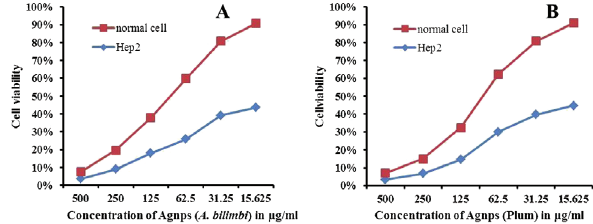
Figure 15: Cytotoxicity studies on Vero and HEp2 cells exposed to Ag NPs synthesized using (a) A. bilimbi leaf extract and (b) Plum fruit extract.